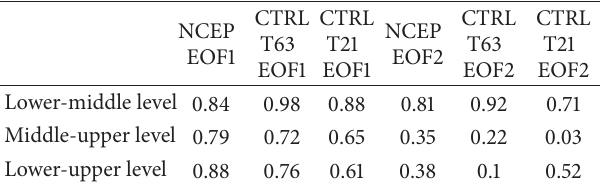
Table 1: Spatial correlation coefficients of dominant variability patterns (EOF1 and EOF2) between the atmospheric levels for reanalysis data and the control runs of the quasi-geostrophic model with T63 and T21 resolution.